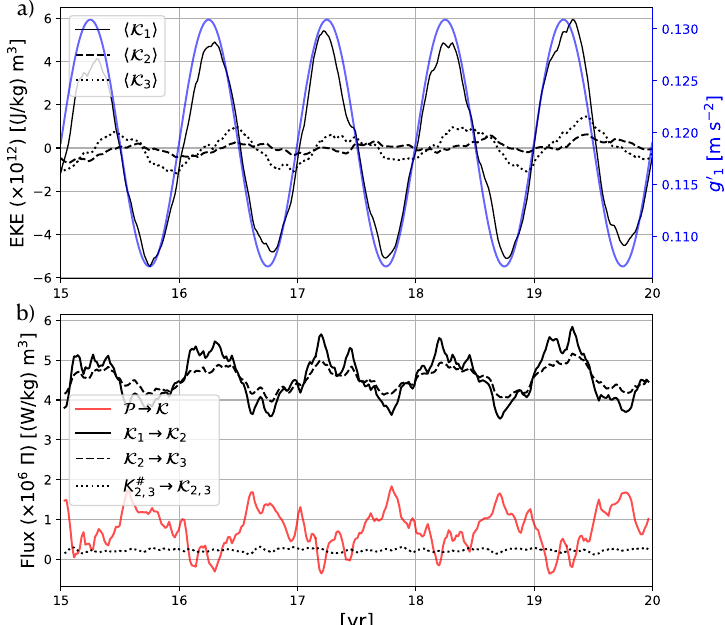
Figure 6. Time series of volume-integrated EKE over each layer, and fluxes within and between layers ( Π K , Π K ) plotted along with the reduced gravity ( g (cid:48) ). ( a ) The EKEs have their temporal 1 2 →K 3 1 →K 2 mean removed so as to plot against the same y axis. ( b ) A rolling mean by five time steps ( ∼ 29 days) is applied to the time series of the energy fluxes. The energy flux from MKE to EKE within the two bottom layers is summed up ( Π ) and conversion from APE is shown as the conversion K # 2,3 →K 2,3 rate volume integrated over the three layers as the amount that goes into each layer is simply the total conversion weighted by layer thickness (cf. Equations (23), (28), (29) and (32)). The conversion from P 1 and P 2 were in sync with each other (not shown). For further details regarding each term, see Appendix